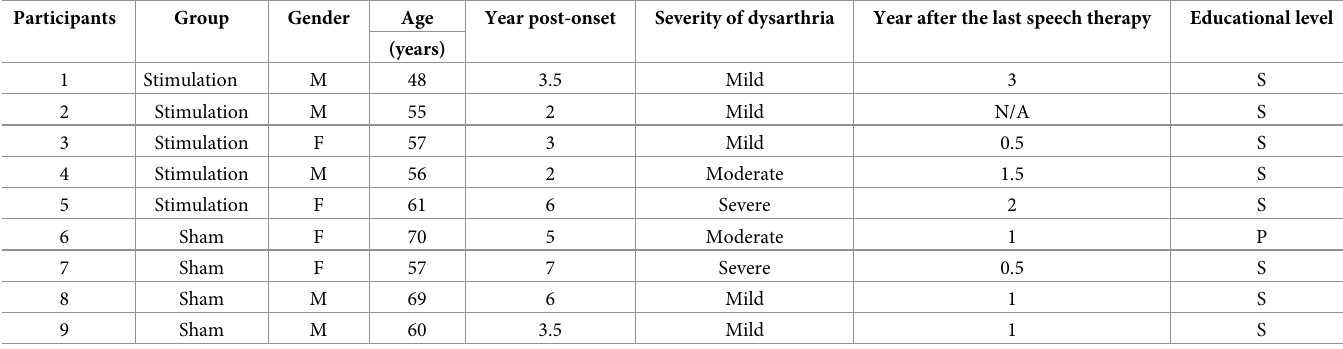
Table 1. Demographic and clinical data of the nine participants.